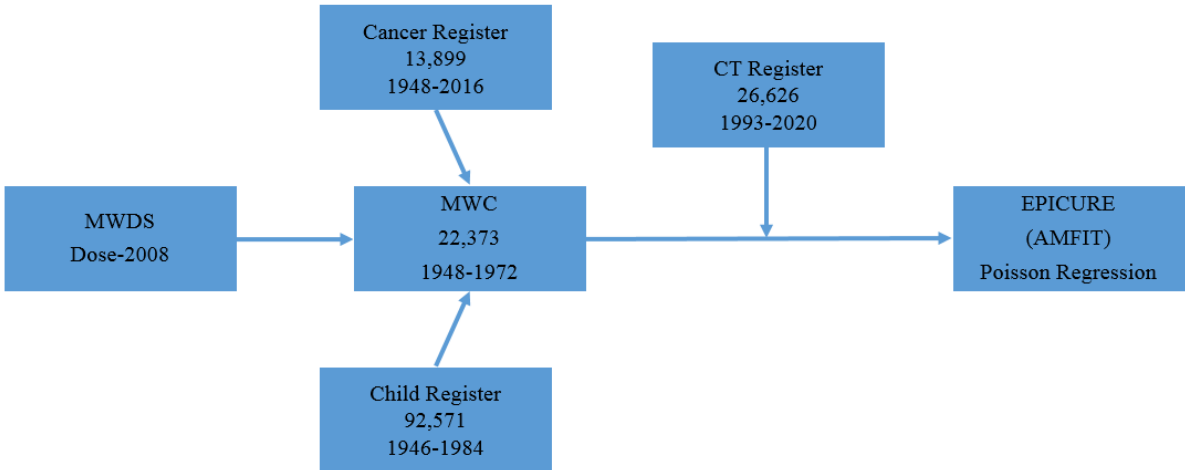
Figure 1. The flow chart of the